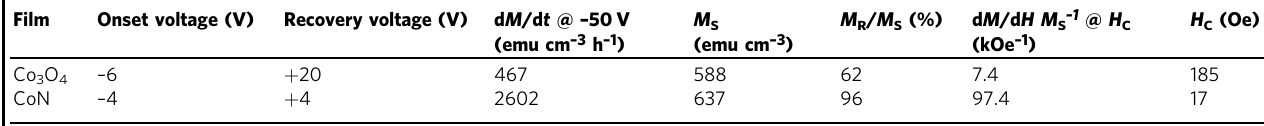
Onset and recovery voltages, magneto-ionicspeed and magneticproperties of the generated ferromagneticphases. Note that M S has been obtained by normalizing the magneticmoment tothe nominal fi lm thickness, without taking into consideration the formation of vacancies or eventual